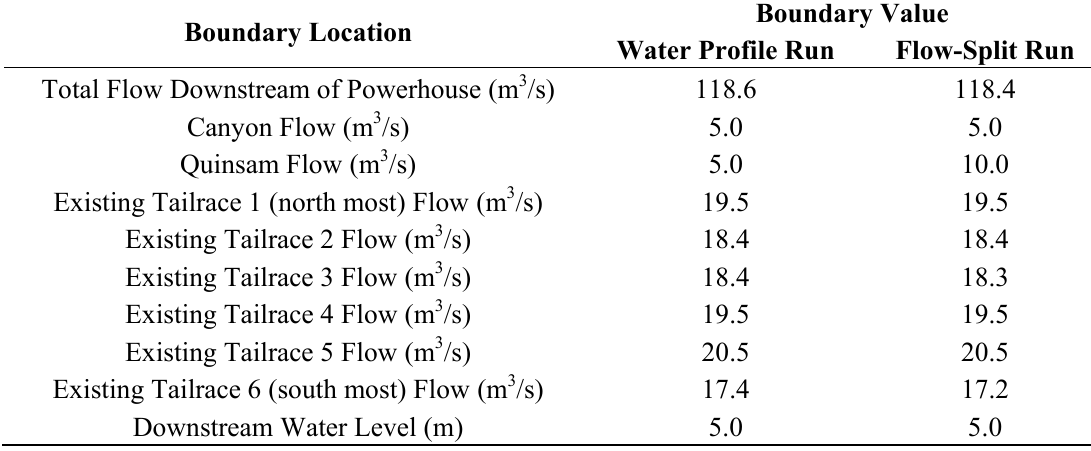
Table 1. Model Inputs for Profile Run and Flow-Split